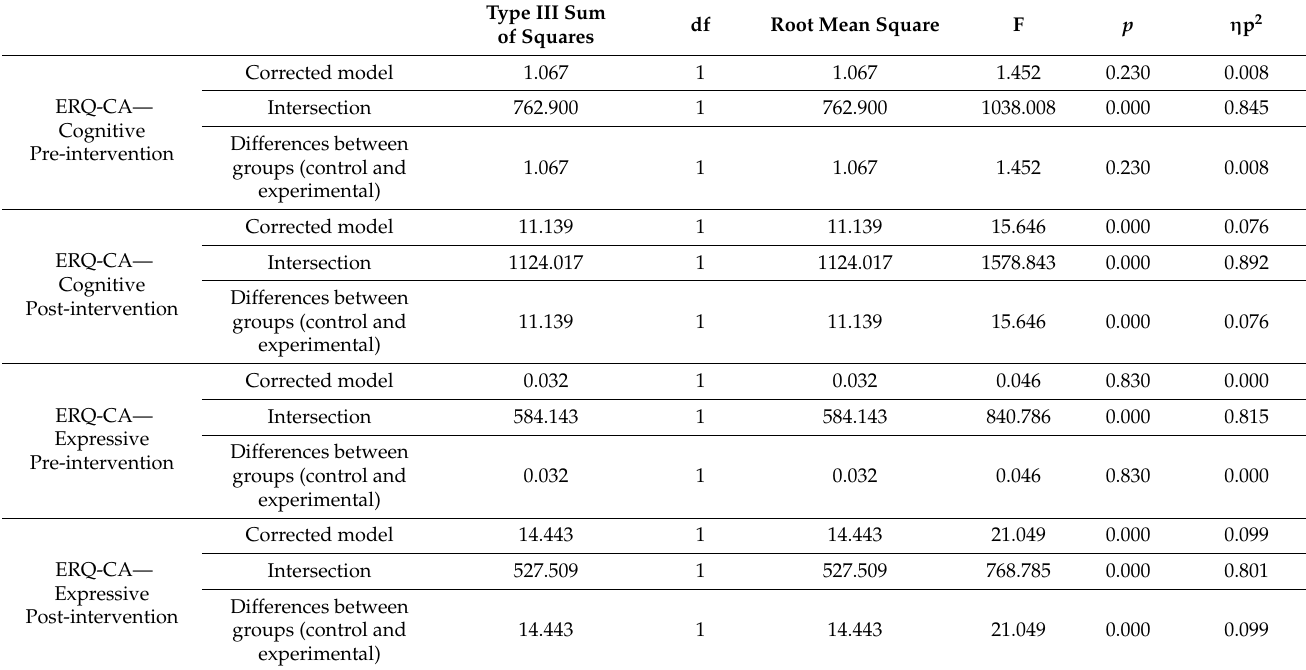
Table 7. Comparison of inter-subject effects for the variables ERQ-Cognitive and ERQ-Expressive at pre- and post-intervention. Type III Sum df Root Mean Square F of Squares